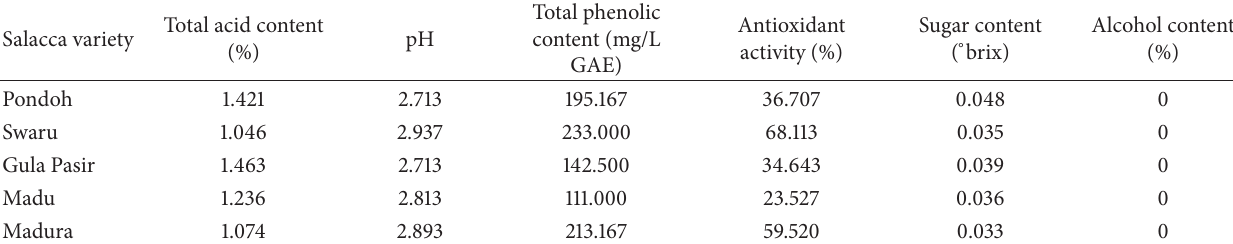
Table 1: Chemical compounds of various salacca